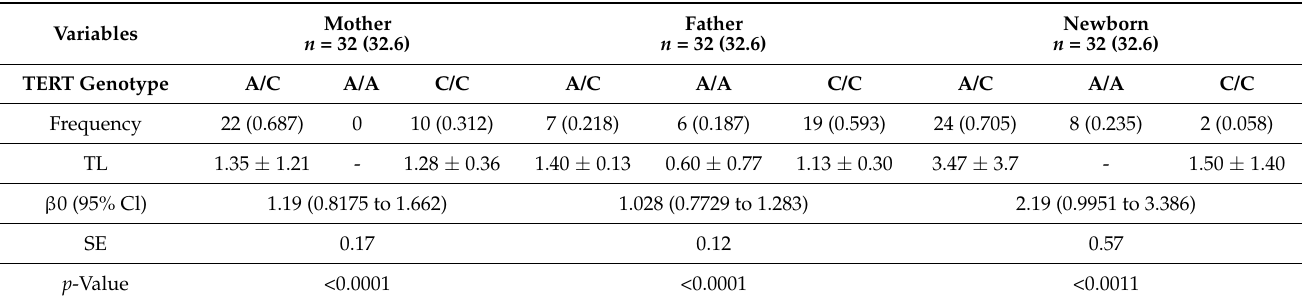
Figure 6. Sanger sequencing of TERT gene. Heterozygous genotype (AC) in both mothers and newborns but homozygous (AA, CC) in the father and newborns. The black arrow shows the SNP C/A allele at the restriction site rs2736100. Table 4. Comparison between the genotype and telomere (TL) among mother, father, and newborn